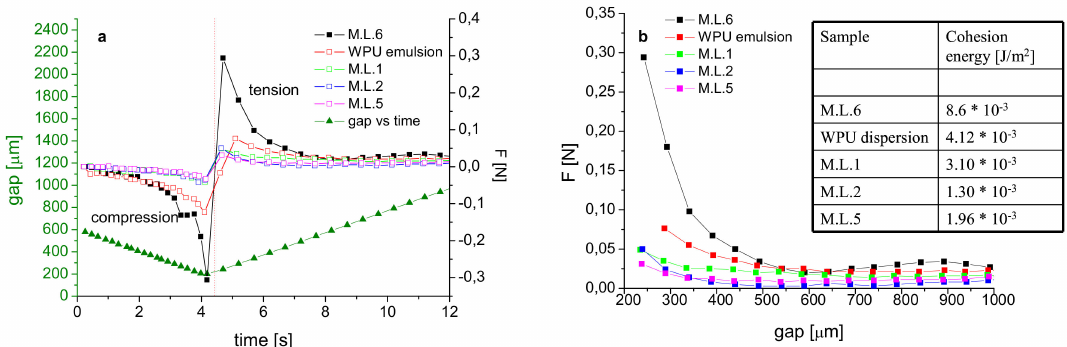
Figure 11. Normal force and gap as a function of time, registered in both compression and tension steps ( a ). Normal force as function of gap in the tension experiment ( b ). The inset table in ( b ) reports the cohesion